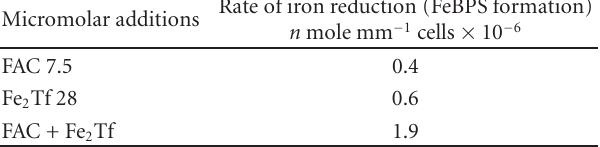
Table 2: E ff ect of diferric transferrin on the rate of iron reduction with ferric ammonium citrate (FAC) by SV403T3 cells. Assay with di ff eric transferrin Fe 2 Tf tested for presence of adventious iron. Data from reference